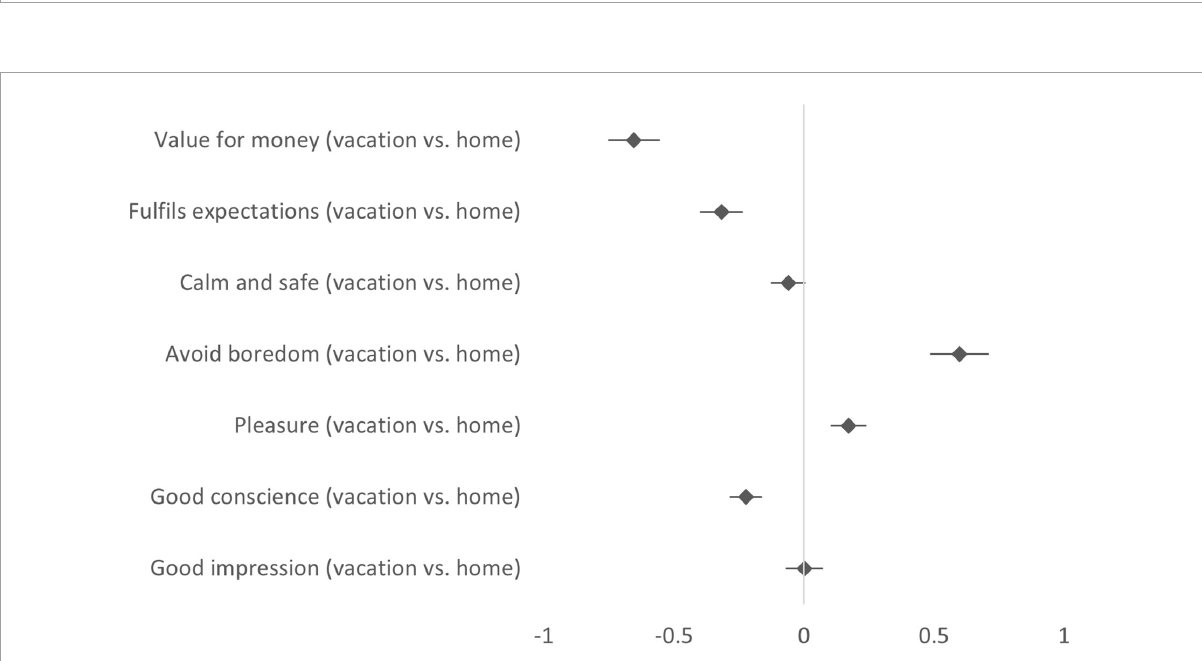
FIGURE2 Consumption motives when visiting a local food market, compared between contexts (answer scale: 1 = Not at all important, 7 = Extremely important). Mean differences (diamonds) are shown with 95% confidence intervals (bars). A positive value indicates that the importance of the motive was rated stronger in the vacation scenario than in the home scenario, a negative value indicates that it was rated